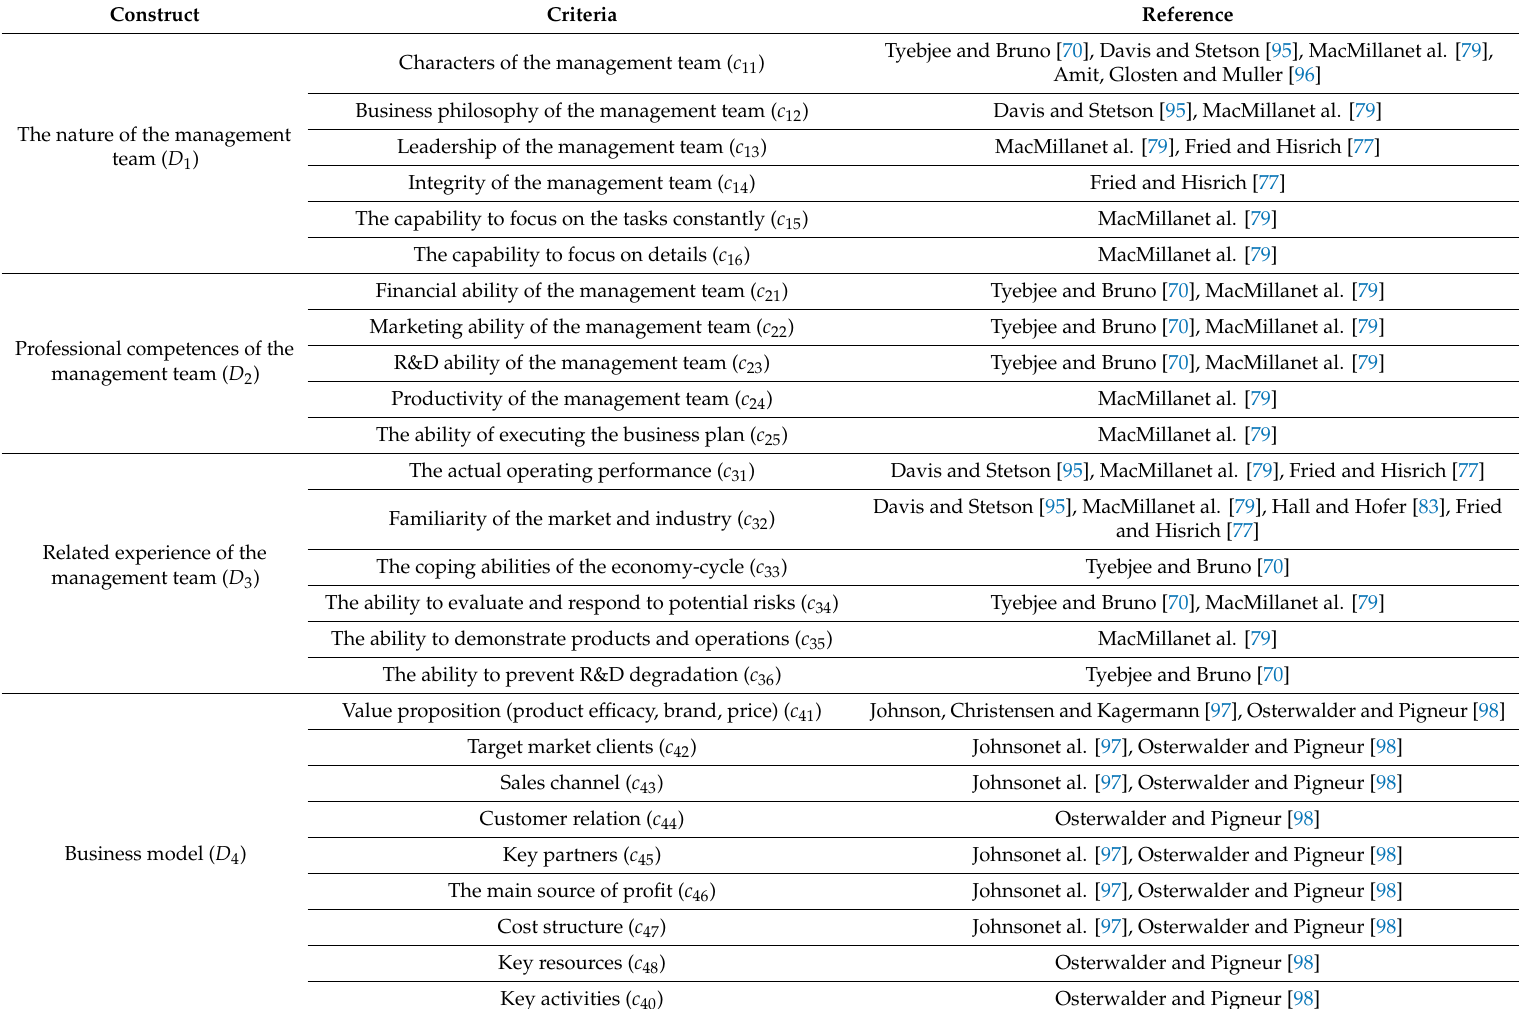
Table 3. Criteria Definitions and